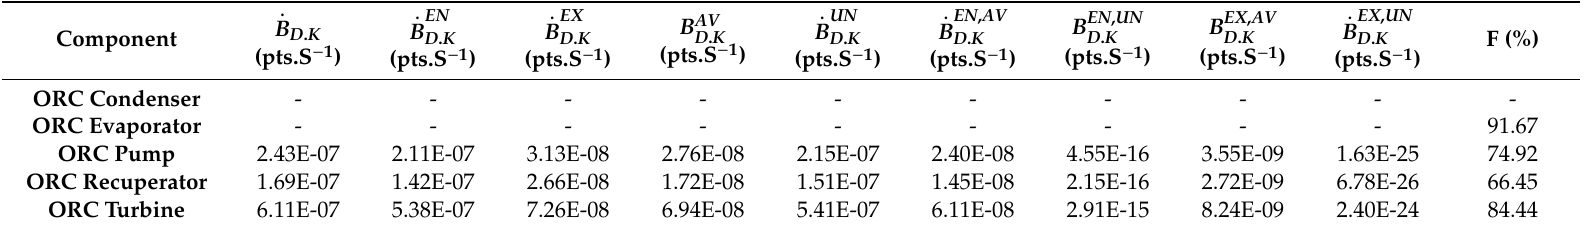
Table 17. Advanced exergo-environmental analysis for the standalone geothermal cycle (GPP).